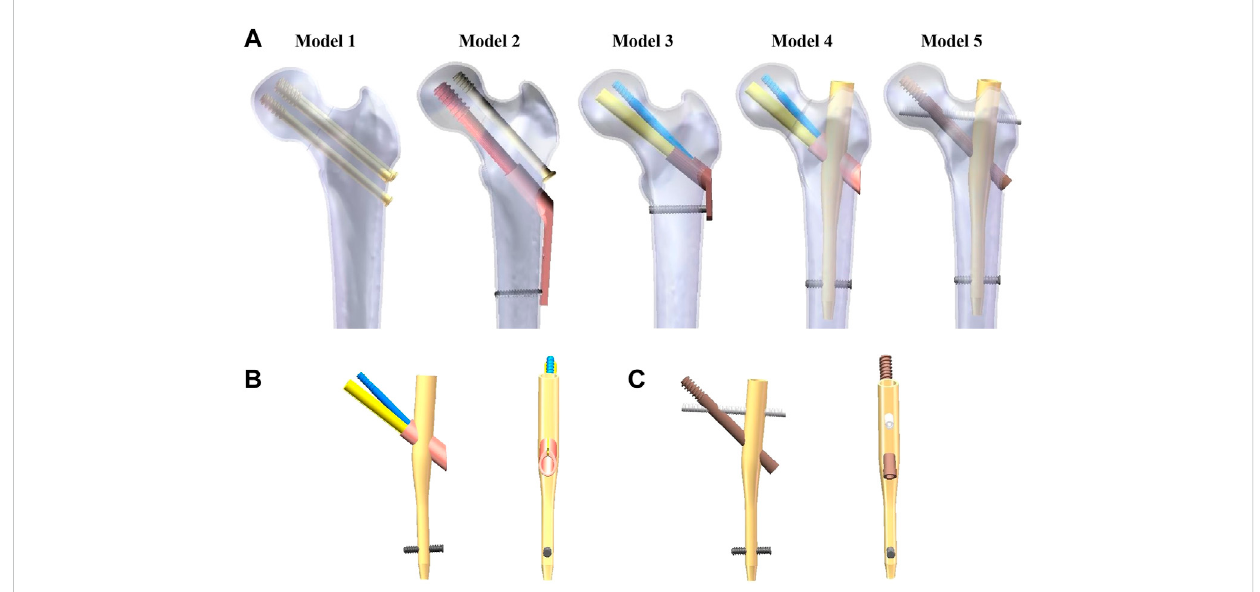
FIGURE 1 Five different implants after assembly of the fi nite element model. (A) Fixation of fi ve different implants in the UFNF. (B) Schematic diagram of the modi fi ed intramedullary femoral neck system. (C) Schematic diagram of the modi fi ed intramedullary interlocking system. UFNF stands for unstable femoral neck